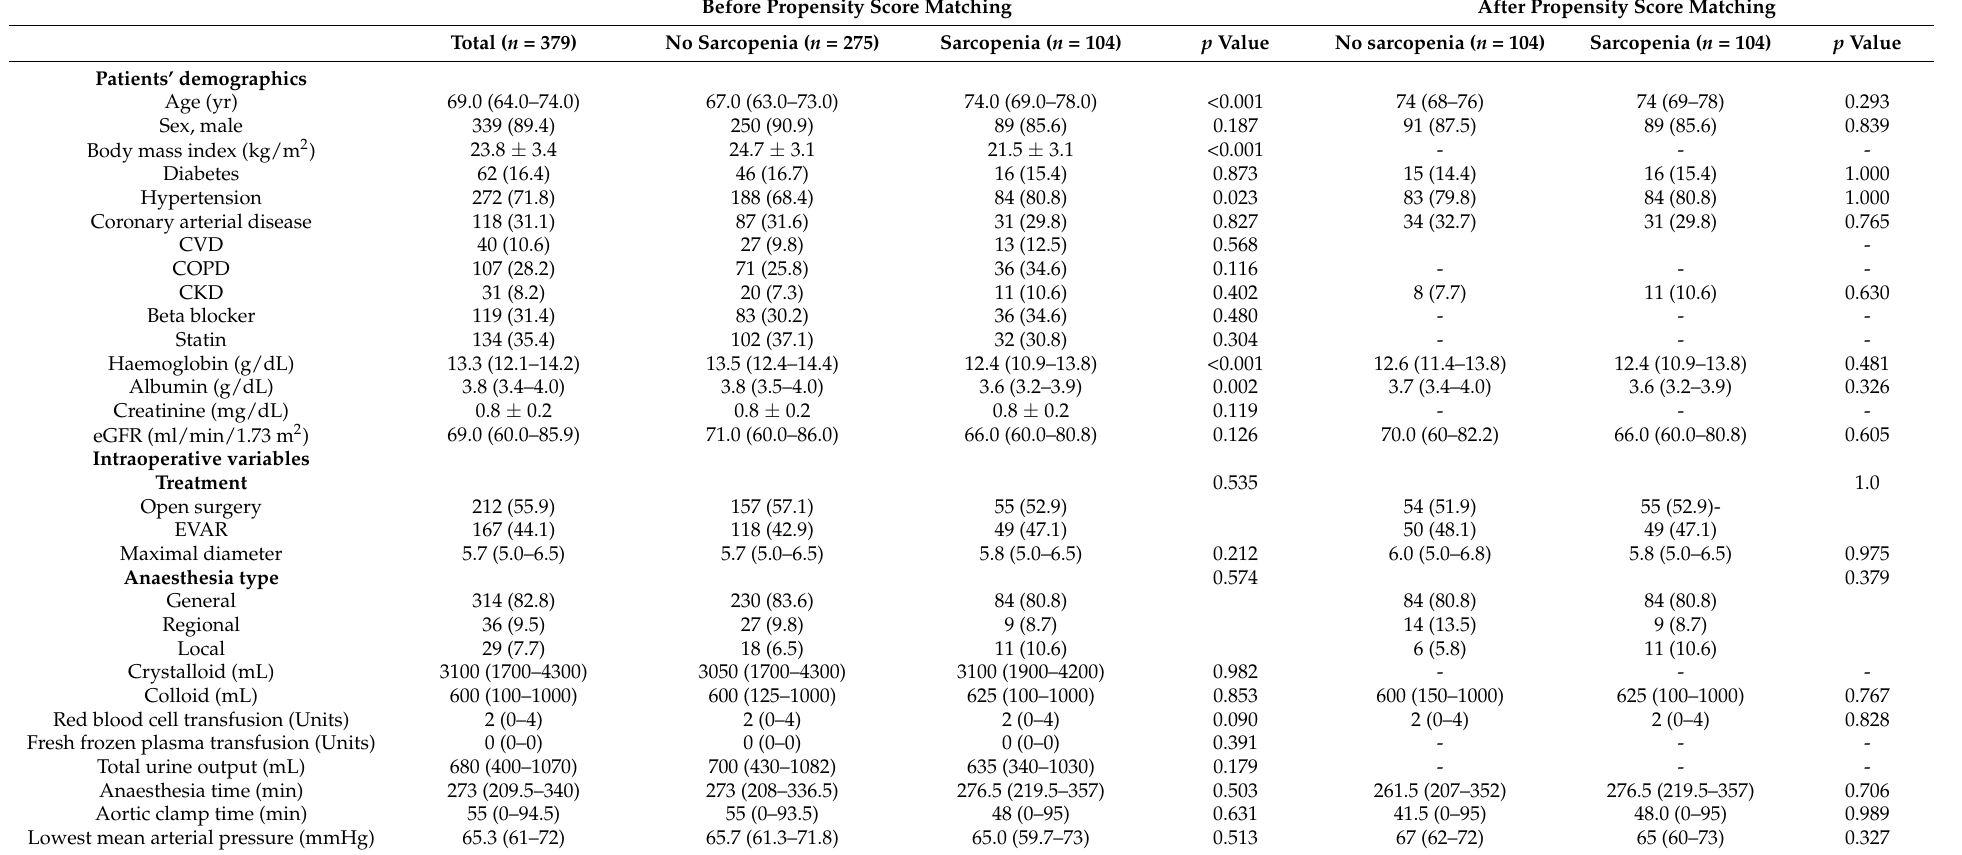
Table 1. Patient demographics and preoperative and intraoperative characteristics according to